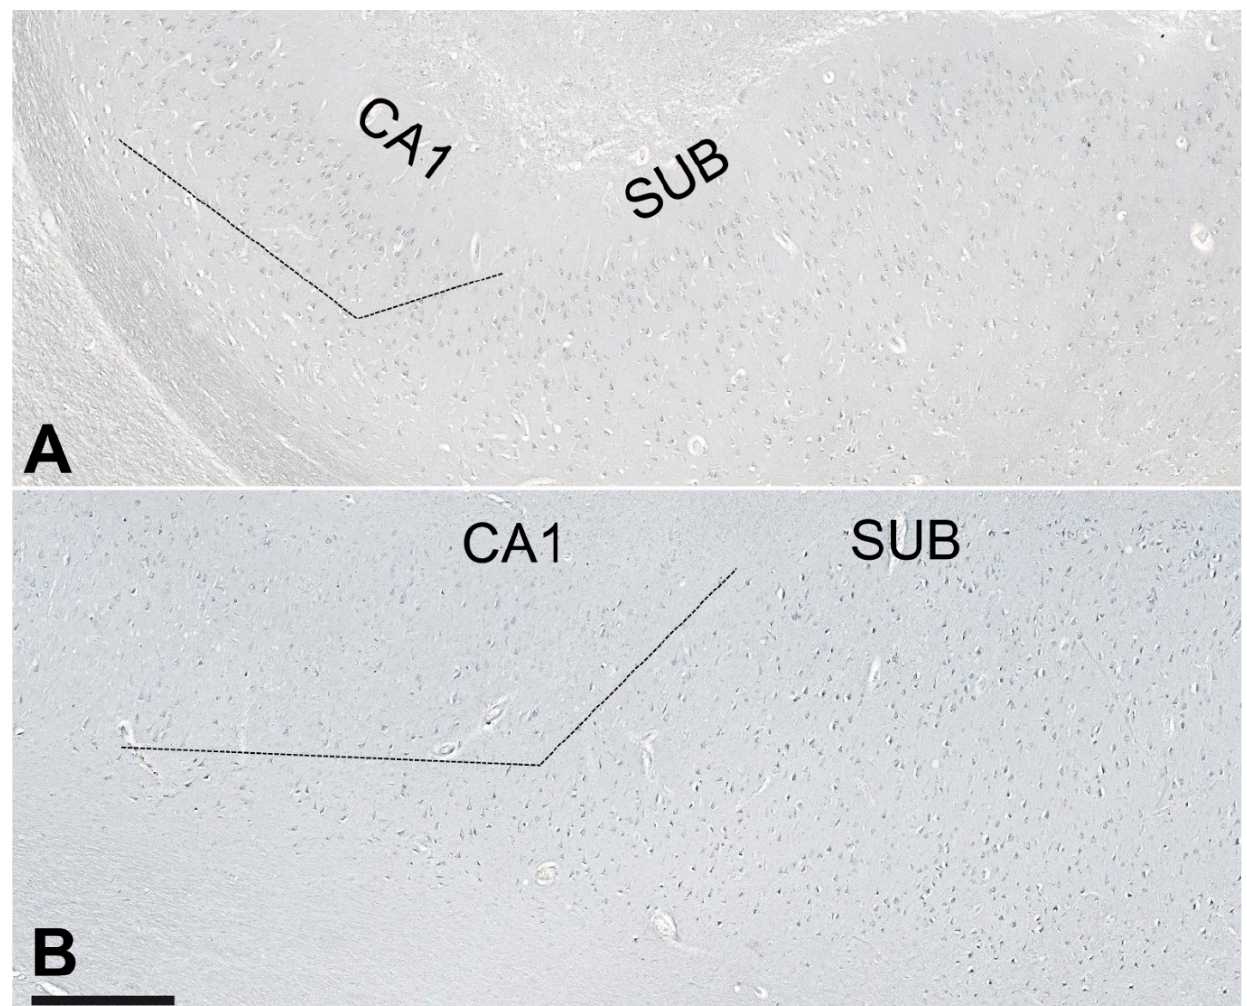
Figure 9. Immunostaining of ASC in the subiculum in control ( A , case HC5) and AD brain ( B , case AD2). The dashed line is a provisional border between the CA1 field and subiculum. The difference in the number of NLRP1-immunoreactive neurons between the HC and AD groups in the subiculum was statistically significant (see Figure 2). Scale bar (same for A and B) = 500 μ m.